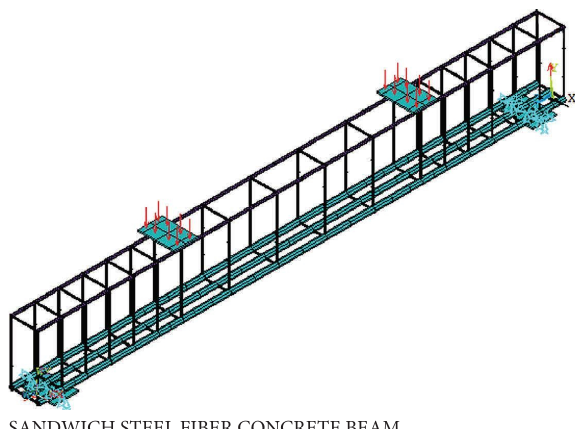
Figure 16: Beam that has had the number of tensile steel bars dropped to 3 ϕ 22.